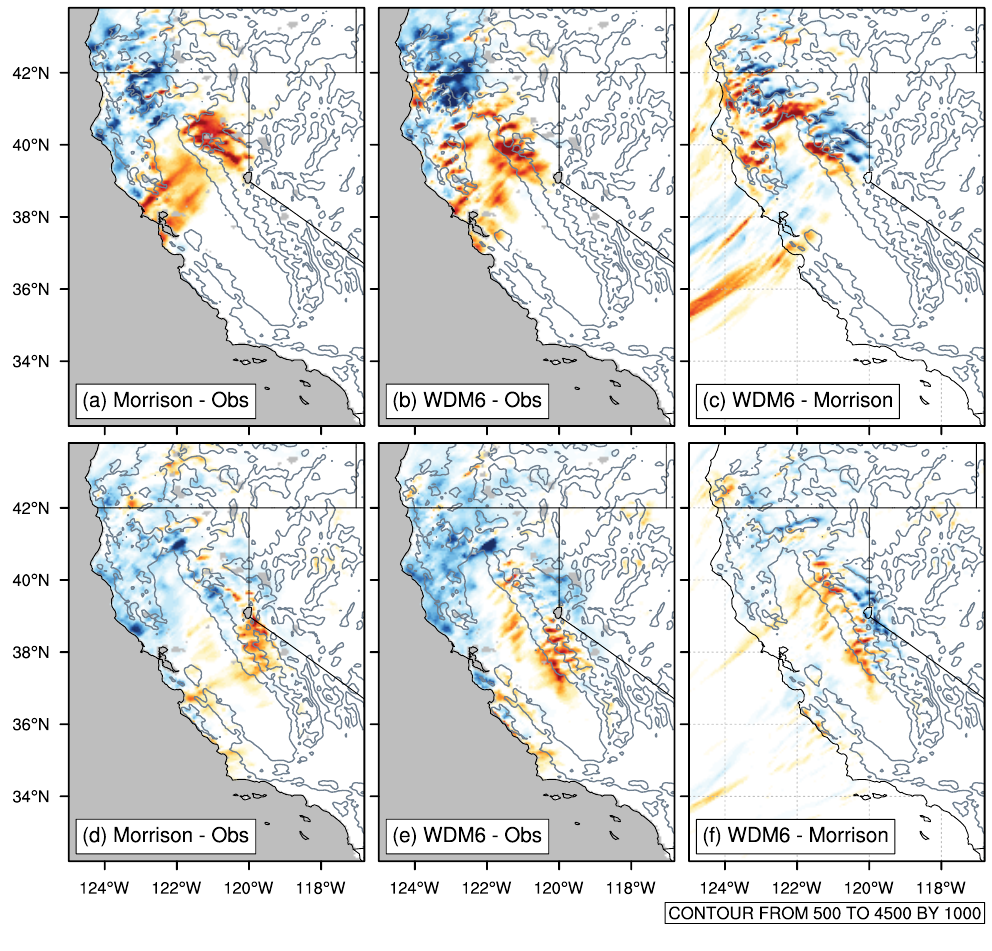
Figure 8. The difference in total accumulated precipitation (shaded, mm) over the 12 h period starting at ( a – c ) 12:00 UTC 6 February 2015 and ( d – f ) 00:00 UTC 7 February 2015. The difference is calculated from (a,d) the Morrison experiment minus the observations, (b,e) the WDM6 experiment minus the observations, and (c,f) the WDM6 minus the Morrison experiments. The height of the topography used in the numerical model is overlain (gray contours, m above sea level), and missing values are indicated by gray